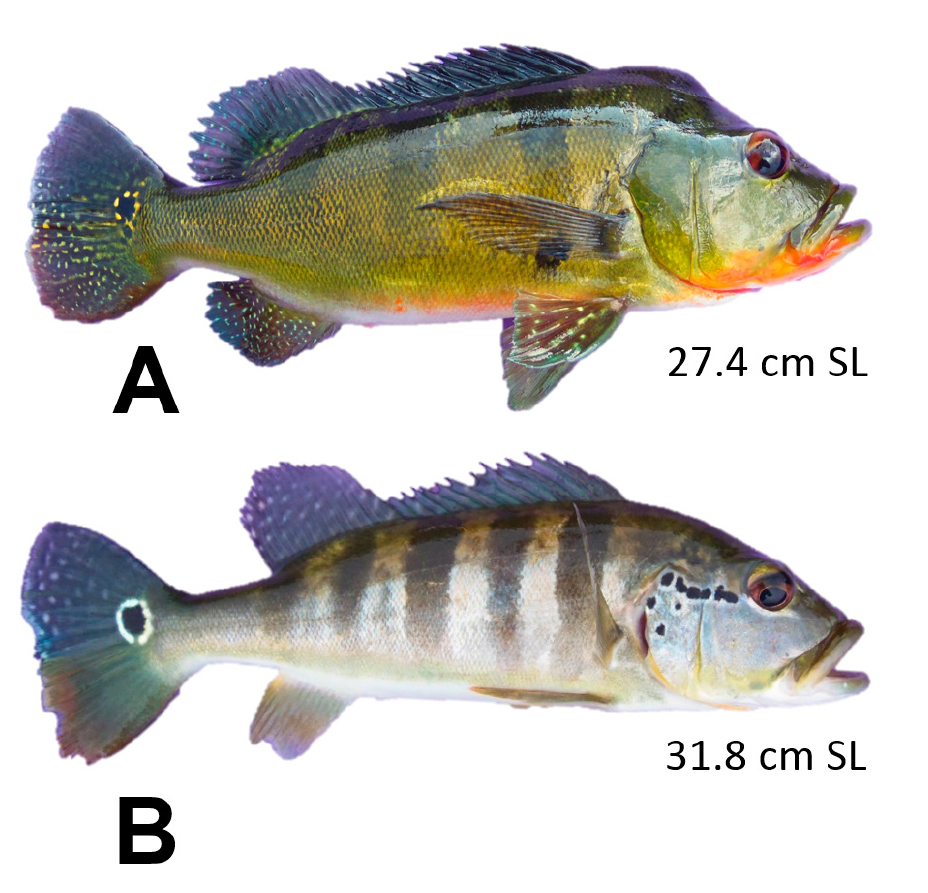
FIGURE 1 | Cichla kelberi ( A ) and C. piquiti ( B ) captured in the Lajeado Reservoir, Tocantins River,